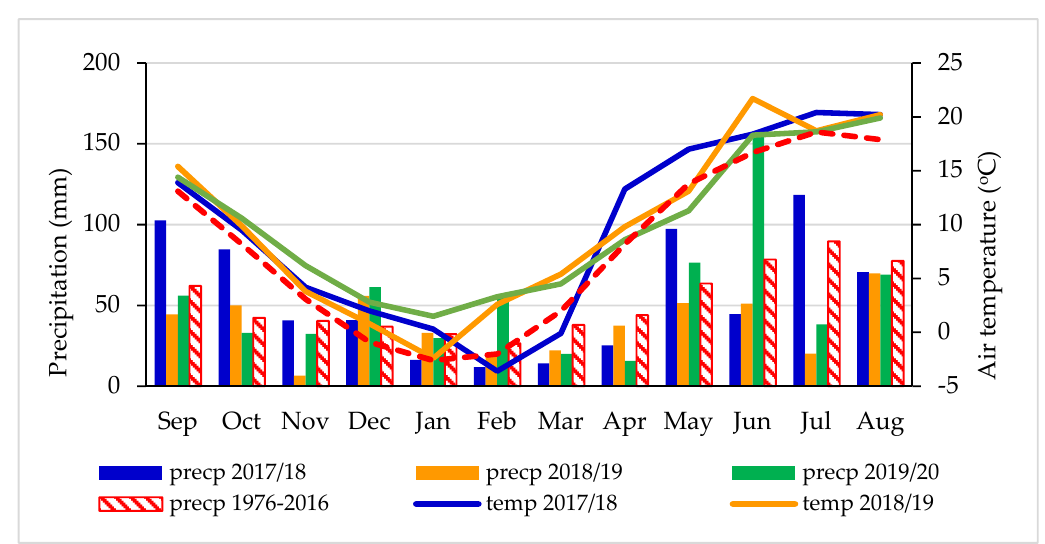
Figure 1. Monthly sums of precipitation (mm) and average air temperatures (°C) and long-term means (1976–2016) at the Grabów Experimental Station.